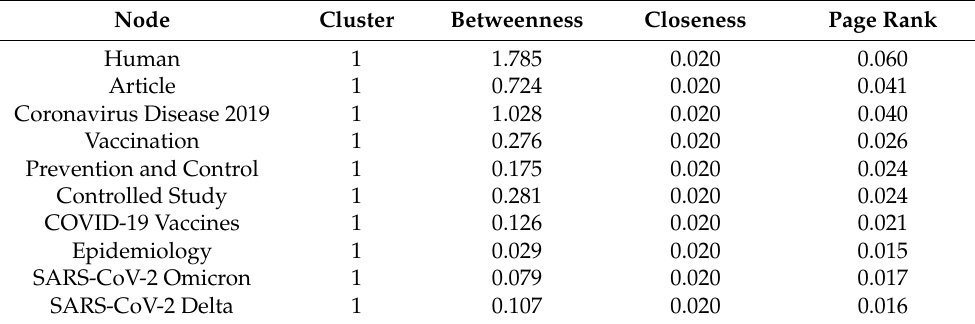
Table 5. Co-word network analysis for Omicron-based research.